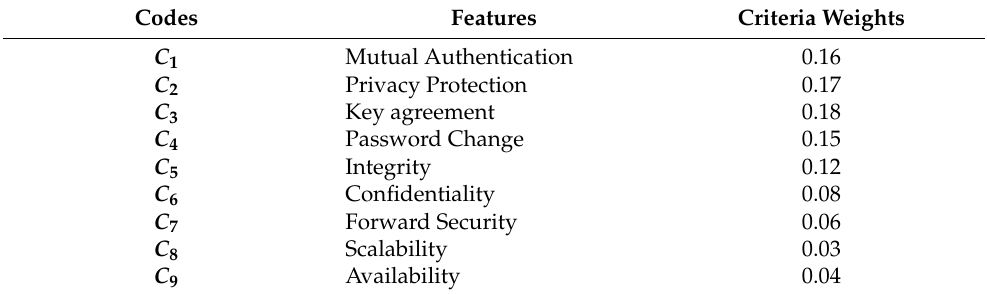
Table 3. Weights of features.